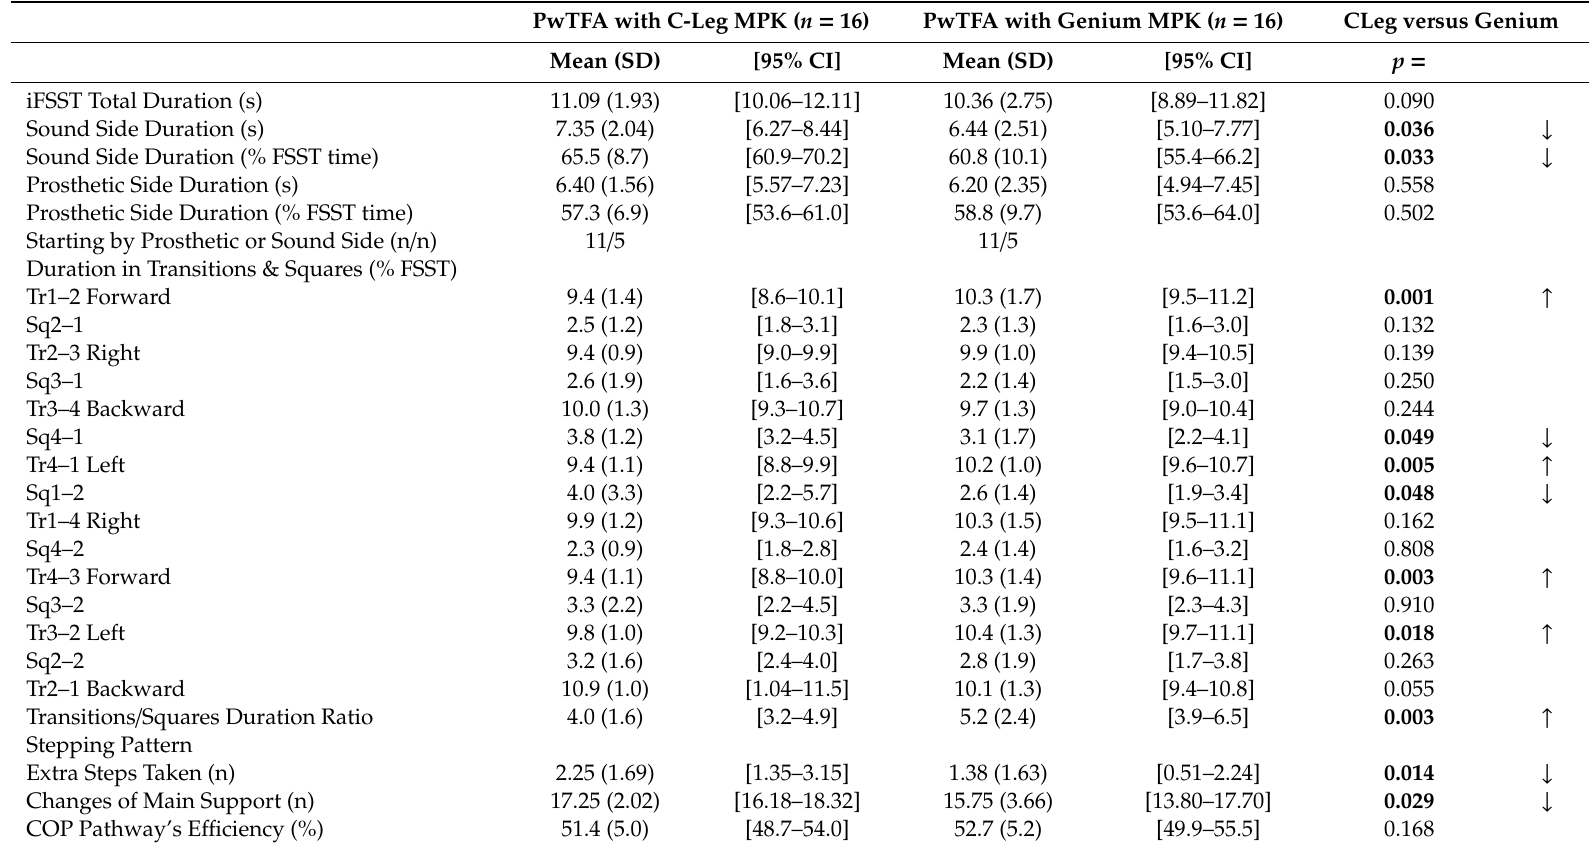
Table 4. Detailed assessments for the iFSST in persons with TFA with the C-Leg or the Genium MPK (standard left and right decomposition). Arrows in the last column indicate the direction of the change (increase or decrease) for variables with significant di ff